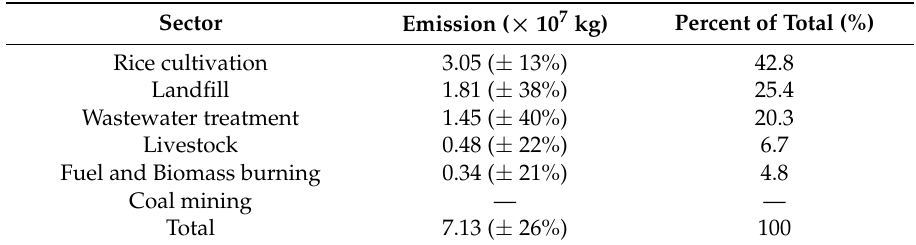
Table 3. Anthropogenic CH 4 emissions in Wuxi in 2012 based on the IPCC inventory